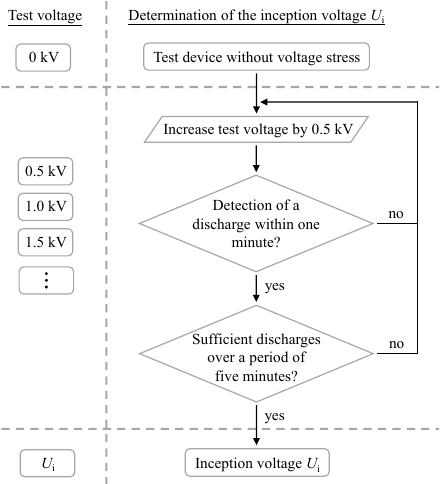
Fig. 4. Flow diagram for the determination of the PD inception